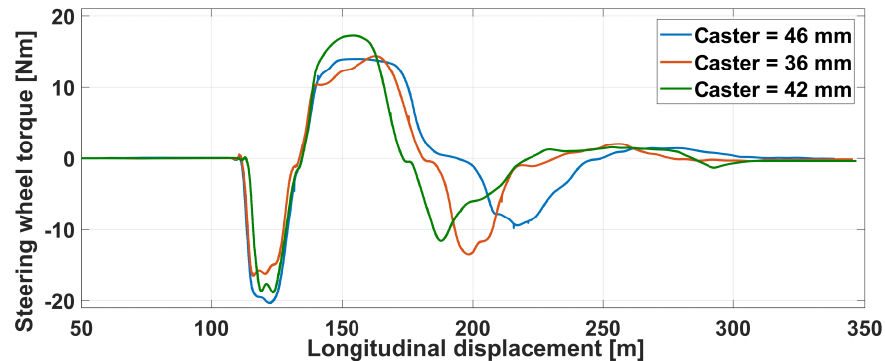
Figure 30. Haptic steering wheel: torque with various